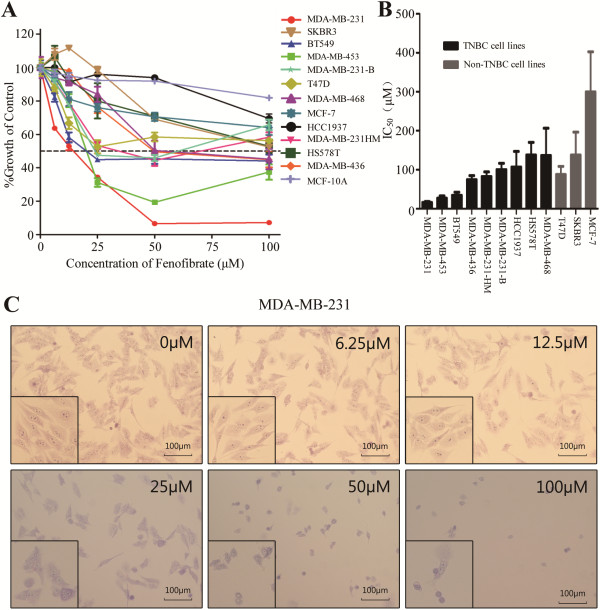
Fenofibrate inhibits breast cancer cells proliferation. (A) Fenofibrate was able to inhibit the proliferation of twelve breast cancer cell lines in a dose-dependent manner, but had the least effect on MCF-10A cells. (B) The 72 h IC50 for each cell line was shown and the first five most sensitive cell lines to fenofibrate were all TNBC cell lines, that were MDA-MB-231, MDA-MB-453, BT549, MDA-MB-436 and MDA-MB-231HM cells, and MDA-MB-231 cells were the most sensitive ones. Data represent the means ± SD of three independent experiments. TNBC = triple-negative breast cancer. (C) A considerable number of MDA-MB-231 cells had morphological changes, including the shrinkage and rounding up of cells when treated with fenofibate.